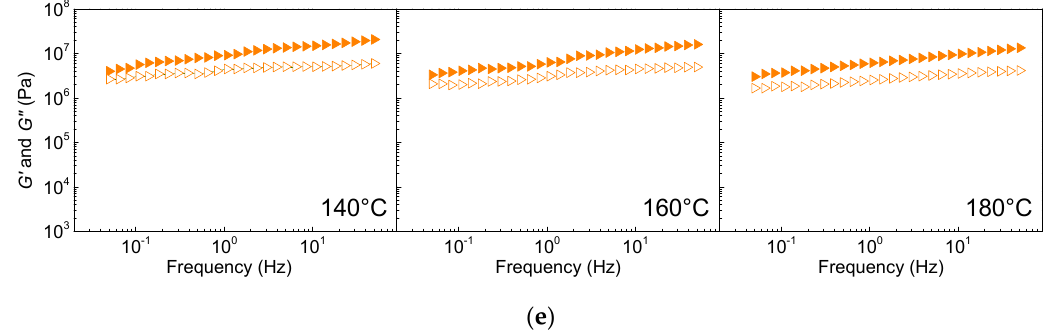
Figure 3. Dependence of storage, G’ (full symbols), and loss modulus, G” (empty symbols), on the frequency for ( a ) neat HDPE, ( b ) HDPE/EG 90/10, ( c ) HDPE/EG 70/30, ( d ) HDPE/EG 50/50 and ( e ) HDPE/EG 30/70 for various temperatures.